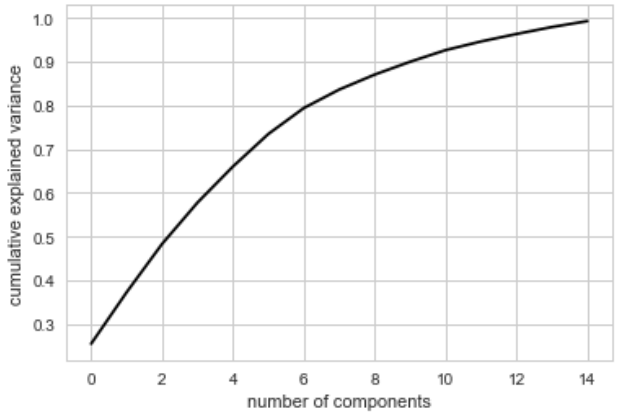
Figure 6. PCA analysis: proportion of variance explained by the principal components of the algorithm. Data = NHANES 2011 – 2012, day 1, women aged 31 – 50 years, non-lactating or pregnant ( n = 155). This shows the amount of variance between each of the nutrients in the model. PCA: principal